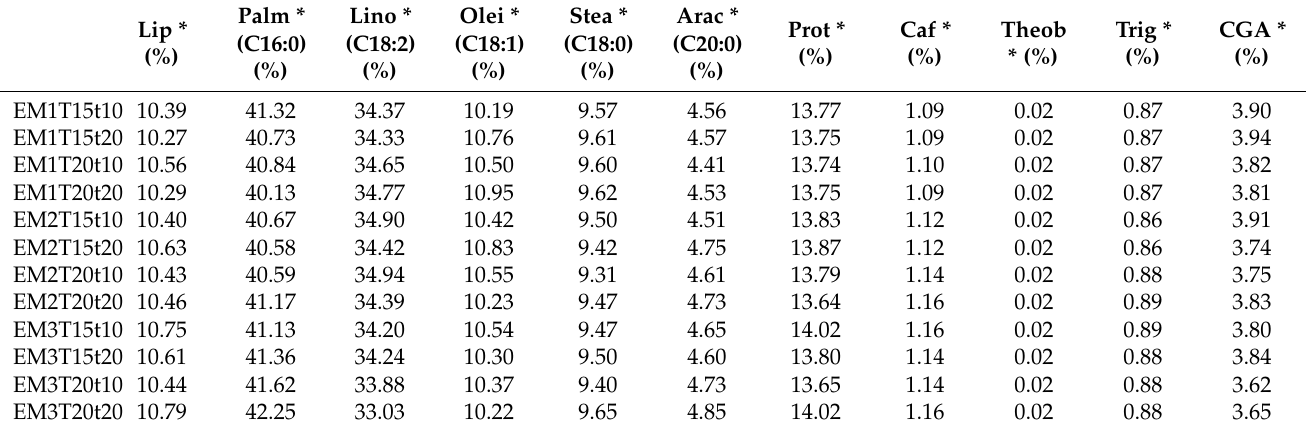
Table 1. Average content of lipids, free fatty acids, protein, alkaloids, and total chlorogenic acids for coffee with different stages of maturity and prolonged fermentation of the mucilage.